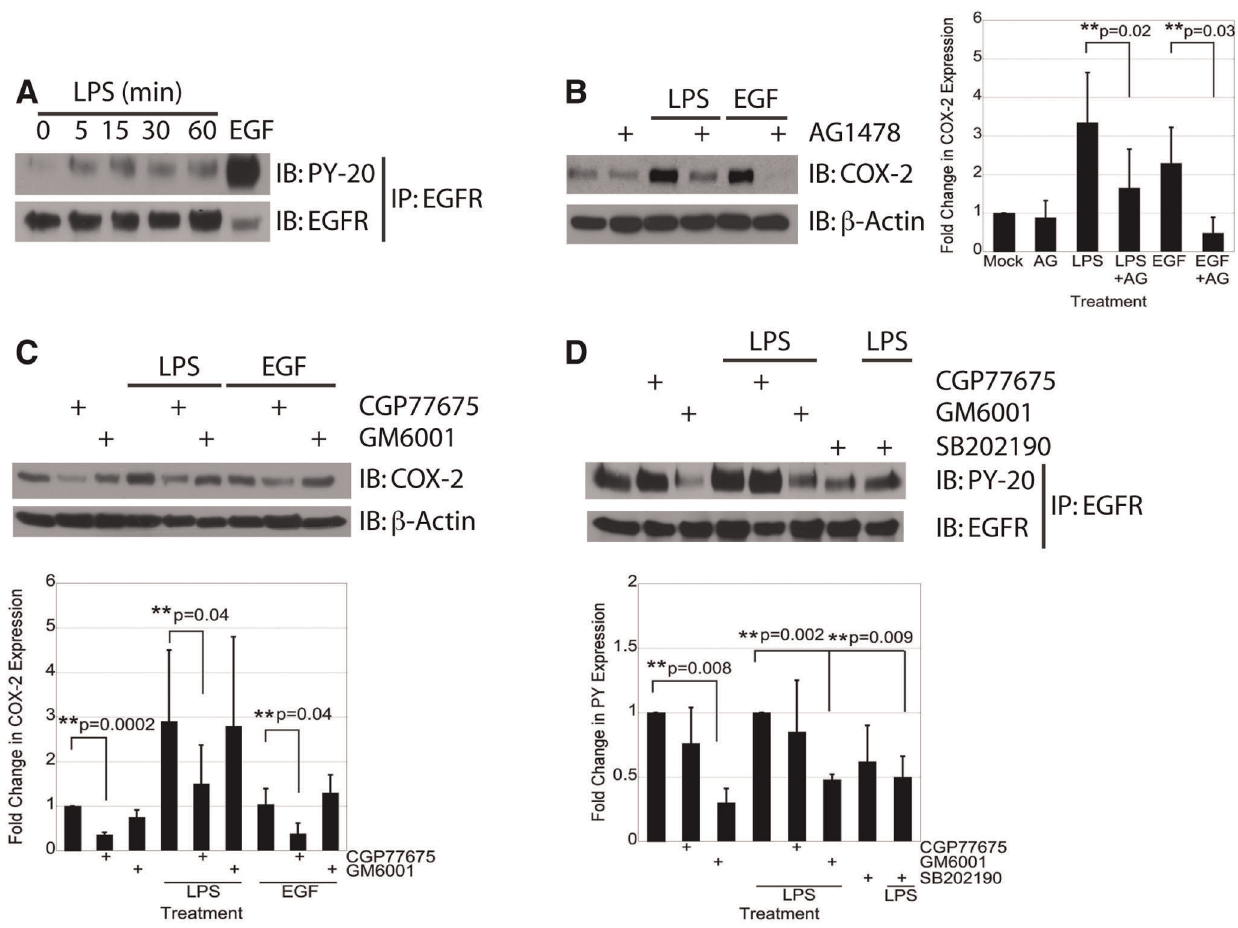
Figure 2. Transactivation of EGFR by LPS induces COX-2 expression in IEC-6 cells in an MMP- and p38-dependent fashion. A) IEC-6 cells were treated with LPS (2 m g/mL) for the indicated time or with EGF (10 ng/mL) for 5 minutes. EGFR immunoprecipitates were assayed for P- EGFR by Western blot analysis. B) Western blot analysis of cells treated with LPS (2 m g/mL) or EGF (10 ng/mL) for 24 hours in the presence or absence of the EGFR kinase inhibitor AG1478 (1 m M). C) IEC-6 cells were stimulated with LPS (2 m g/mL) for 24 hours in the presence or absence of the Src family kinase inhibitor CGP77675 (2 m M) or the MMP inhibitor GM6001 (50 m M). D) IEC-6 cells were stimulated with LPS (2 m g/mL) for 15 minutes in the presence or absence of CGP77675 (2 m M), GM6001 (50 m M), or p38 MAPK inhibitor SB202190 (10 m M). Single asterisks indicate significant differences from control. Double asterisks indicate significant differences between two bracketed conditions.